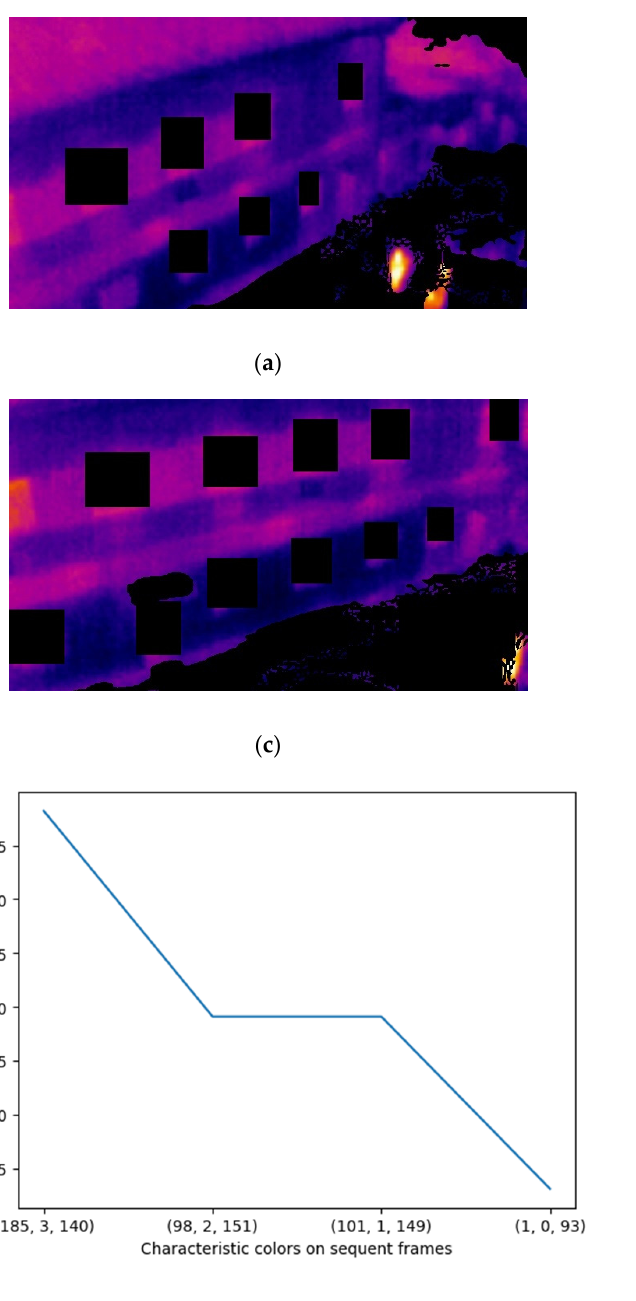
Figure 8. ( a – d ) Subsequent IR frames; ( e ) characteristic color variations.